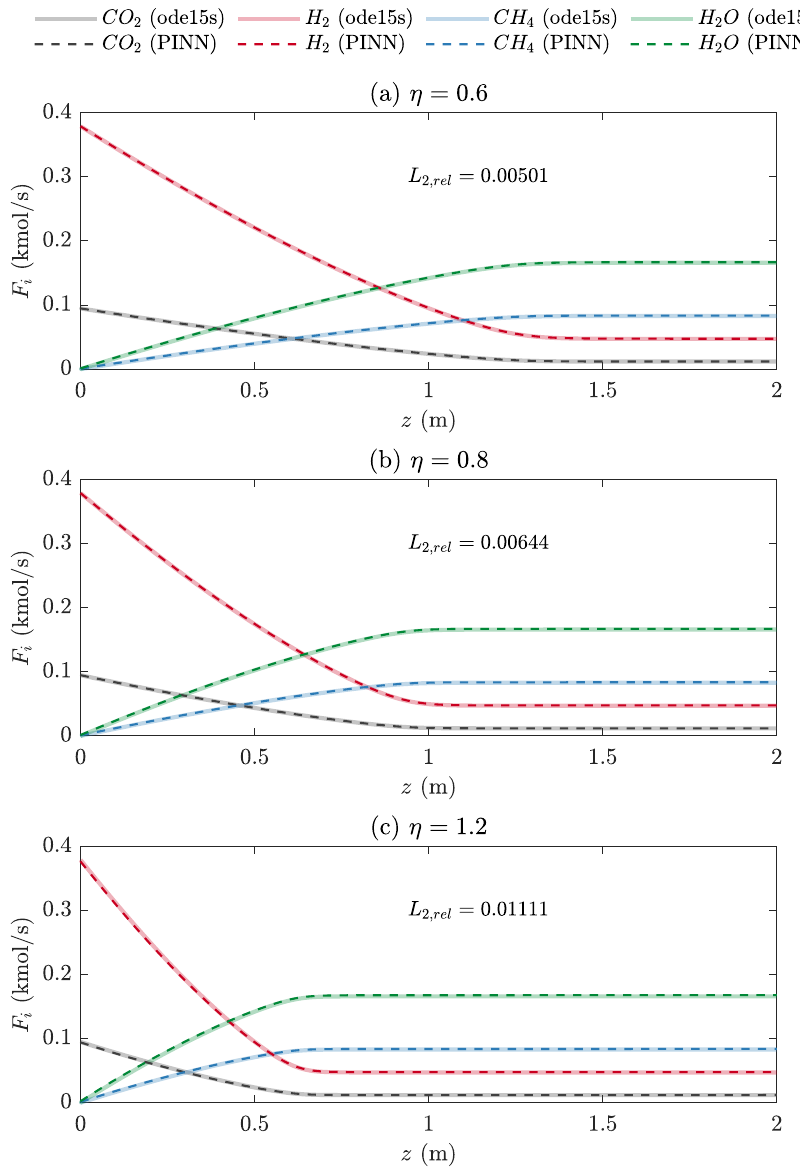
Figure 12. Performance of forward PINN models with two inputs ( z and η ) at η = 0.6 ( a ), 0.8 ( b ), and 1.2 ( c ).